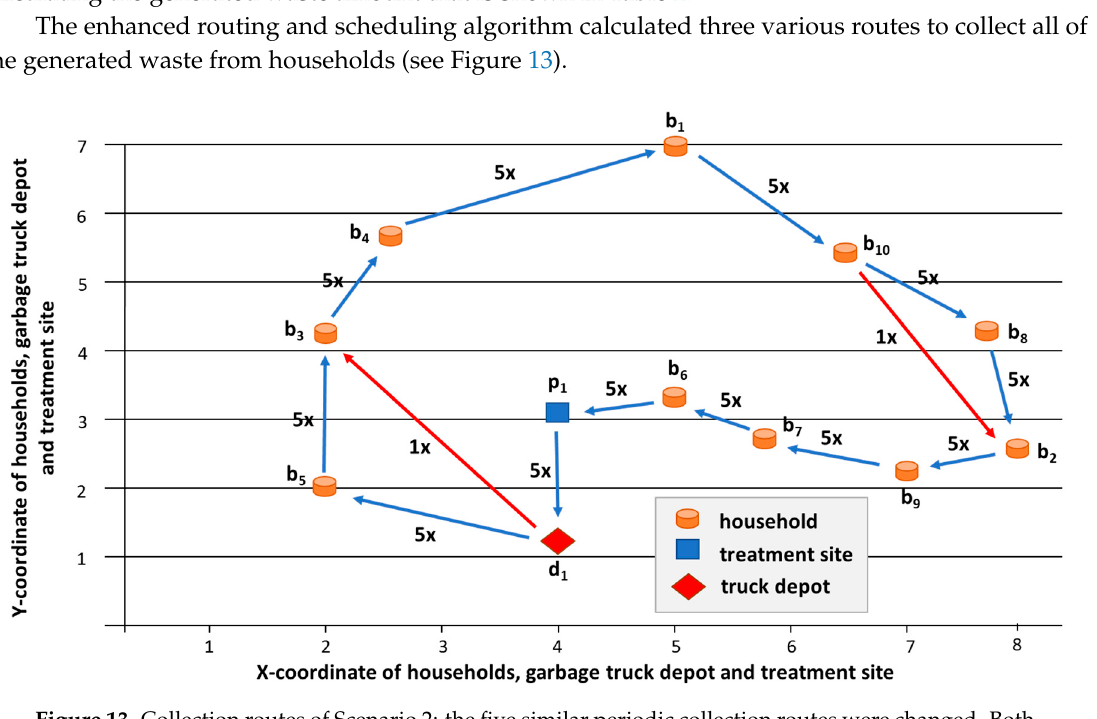
Figure 13. Collection routes of Scenario 2: the five similar periodic collection routes were changed. Both the scheduling and the sequence of households were rescheduled to reduce the emission to increase the environmental awareness of the collection process. The optimization algorithm resulted in a emission reduction of 14.78%.